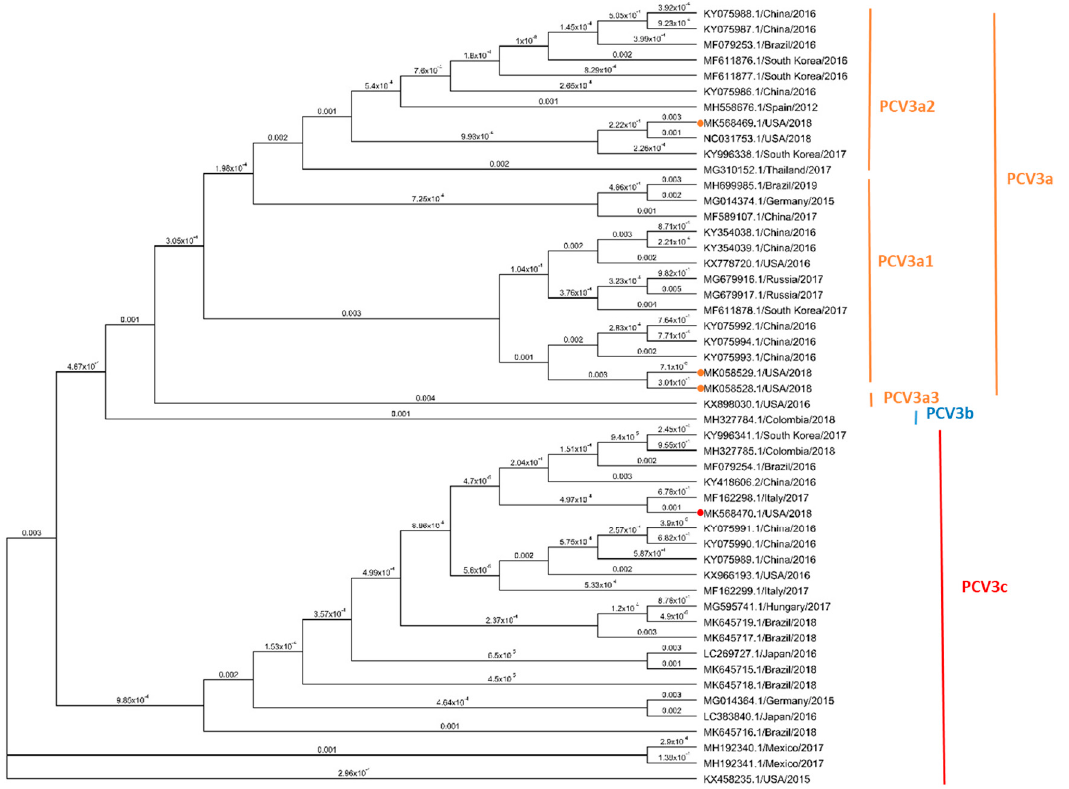
Figure 4. Phylogenetic analysis based on four complete genome sequences of three PCV3 isolated and 46 reference strains. The solid circles indicate the sequences of four viruses isolated in this study. Maximum parsimony (MP) tree based on the nucleotide sequences of the whole genome was protein reconstructed using Geneious R9 software. The value along the branches represent substitutions per site. The clade of trees was estimated using 1000 replicates of bootstrap (BT) analysis. All PCV3 strains were divided into three clades, PCV3a (orange), PCV3b (blue) and PCV3c (red). PCV3a was further divided into three subclades.